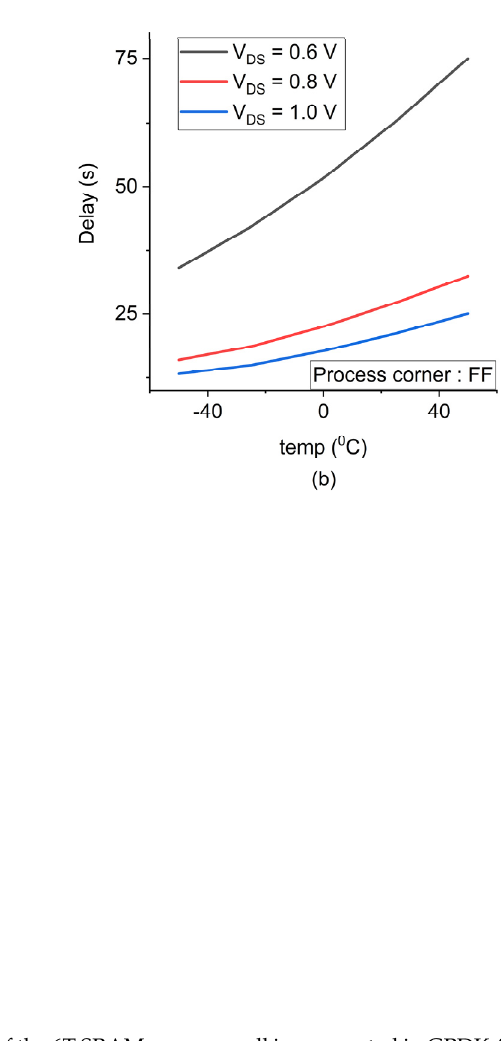
Figure 14. ( a – c ) Extracted delay of the 6T SRAM memory cell incorporated in GPDK 45 nm technology with respect to process corners (nominal, FF- Fast Fast, SS- Slow Slow), supply voltage ranging from 0.6 to 1.0 V and temperature from − 50 °C to +50 °C.